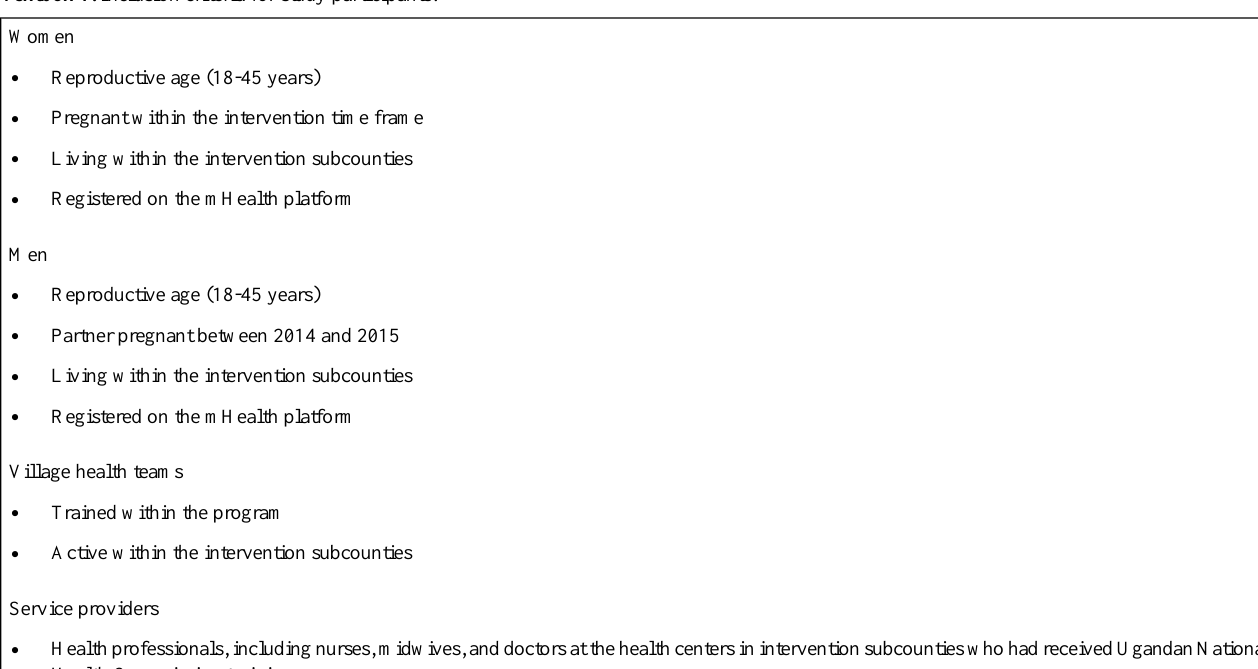
Textbox 1. Inclusion criteria for study